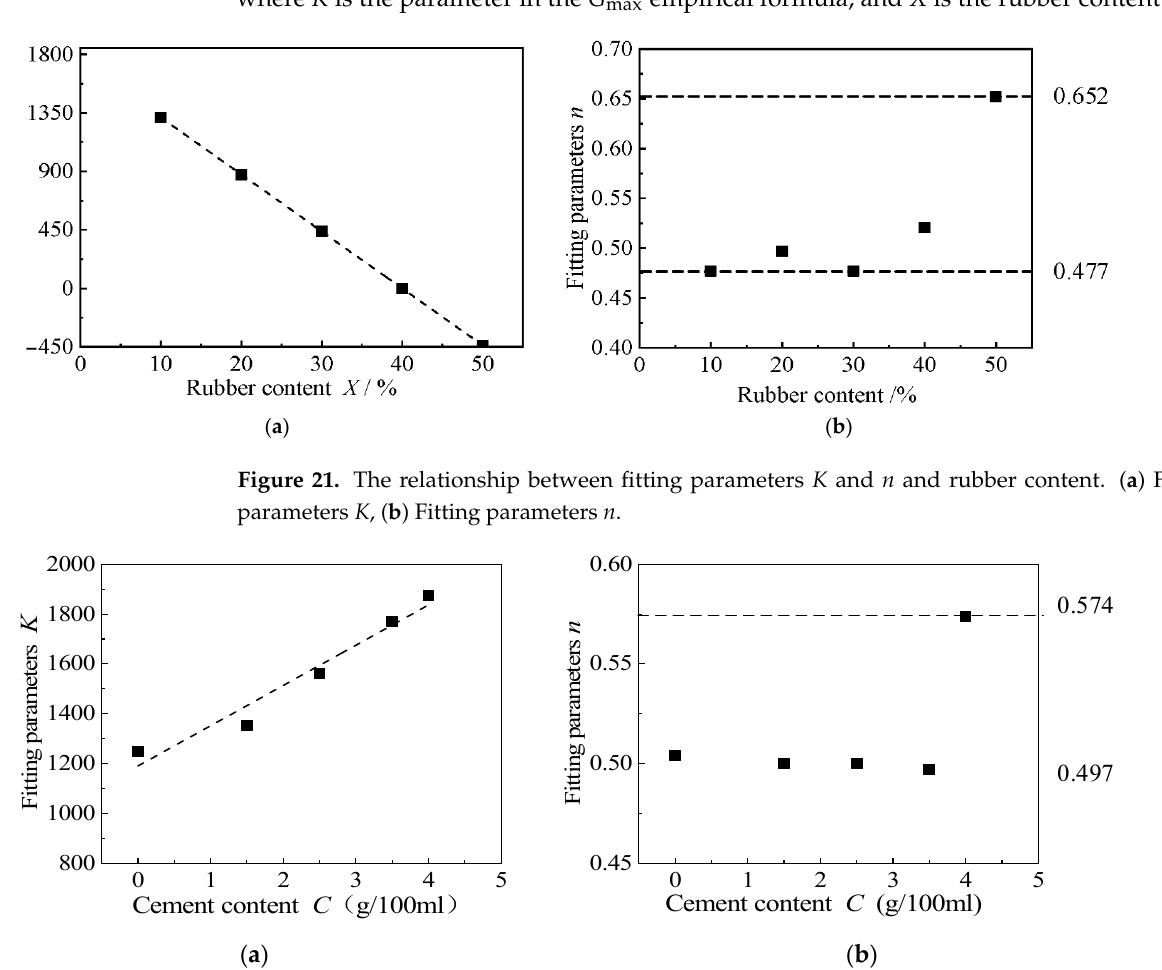
Figure 22. The relationship between fitting parameters K and n and cement content. ( a ) Fitting parameters K , ( b ) Fitting parameters n.